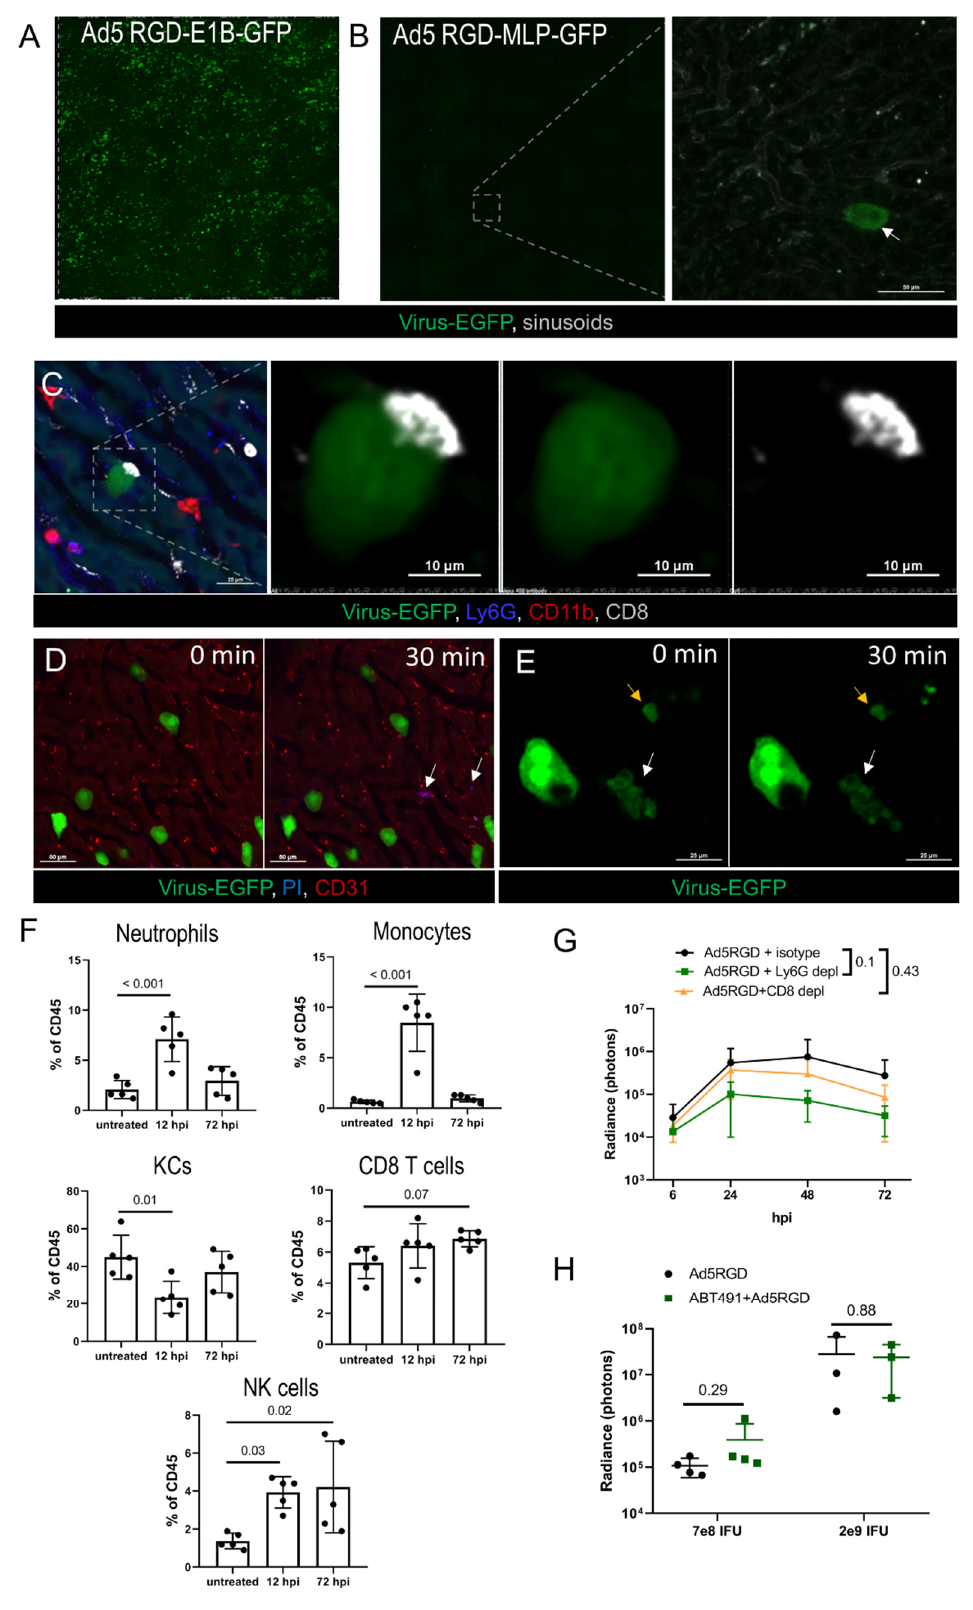
Figure 3. Immune response and clearance of liver infection. ( A , B ). IVM-images of the liver at 72 hpi of Ad5-RGD vectors (1.6 × 10 9 IFU) with EGFP expression under control of early ( A ) or late ( B ) viral promoter. Arrow indicates an extremely rare finding—EGFP expression driven by late